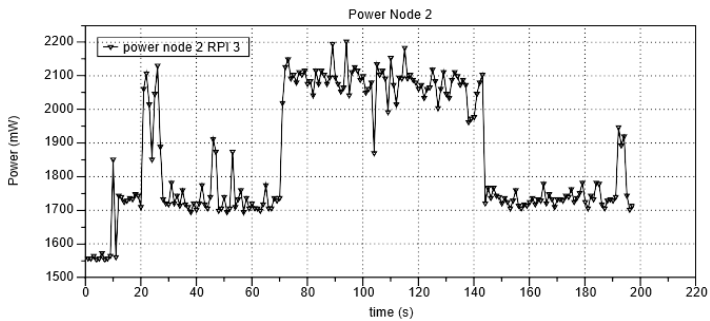
Figure 14. RPI node 2 power consumption.